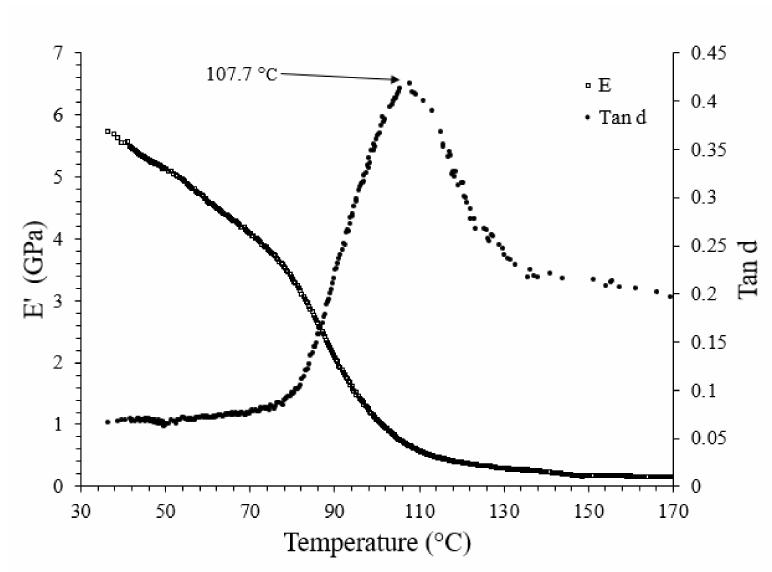
Figure 10. Average Tg as obtained from DMA